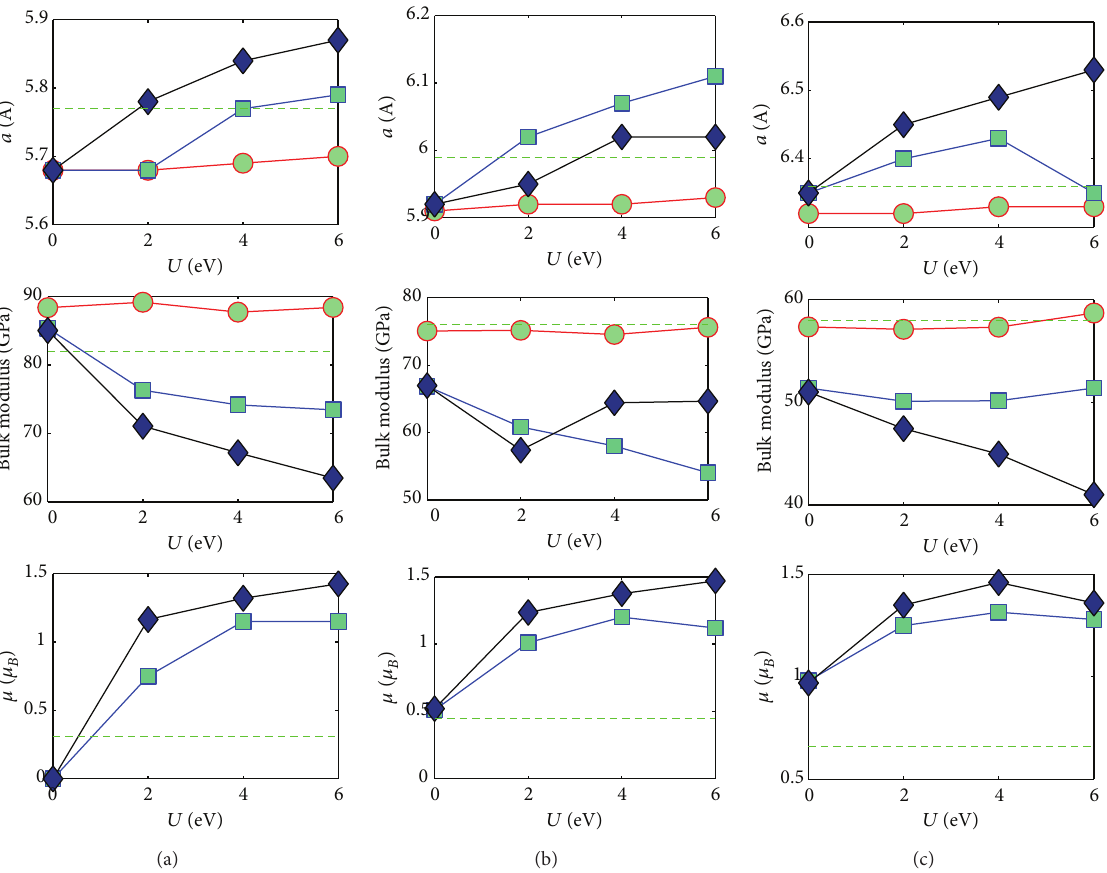
Figure 2: 𝑈 dependence of the equilibrium lattice constant (first row), bulk modulus (second row), and magnetic moments (third row) for (a) CeS, (b) CeSe, and (c) CeTe. Circles (nonmagnetic), squares (ferromagnetic), and diamonds (antiferromagnetic) are obtained from a fit of the static energy at different lattice constants to a third order Vinet equation of state for the lattice constant and the bulk modulus and the calculated equilibrium magnetic moments for the ferro- and antiferromagnetic configurations (third row). In all subplots, the dotted thick line represents the experimental value of the plotted quantity which is quoted in Table